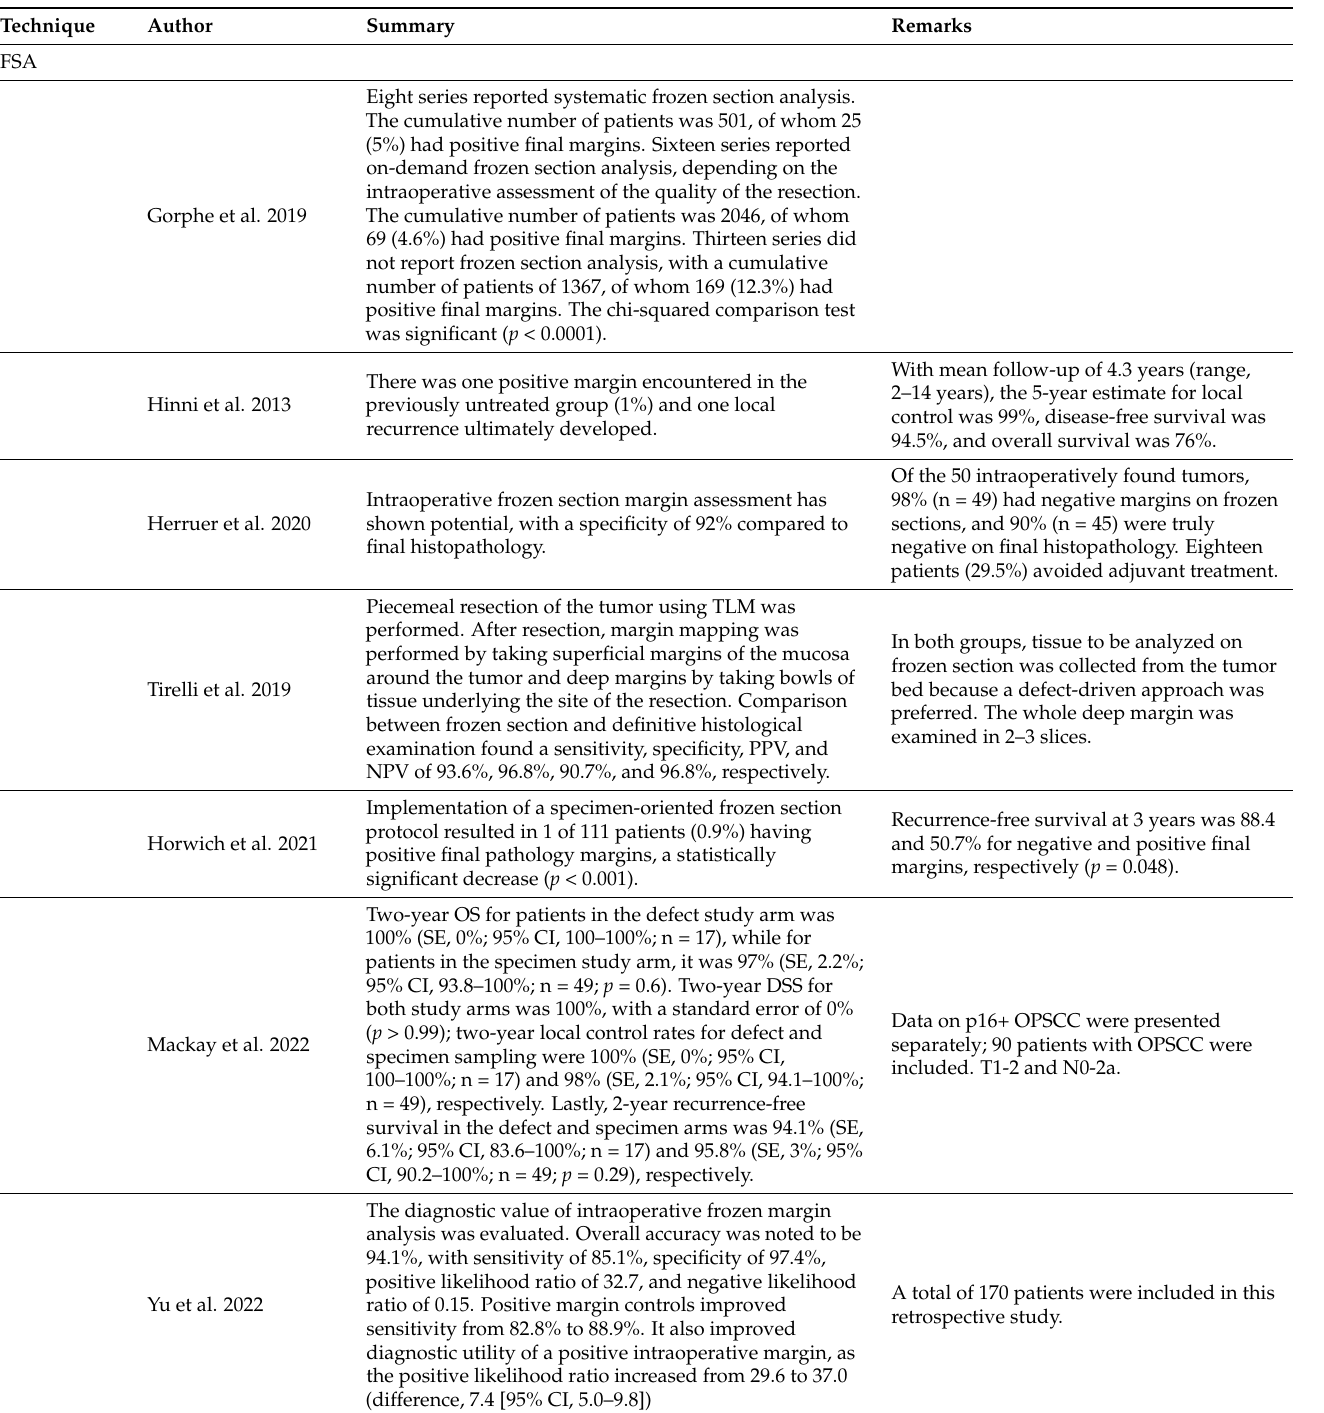
Table 2. Summary of articles organized by